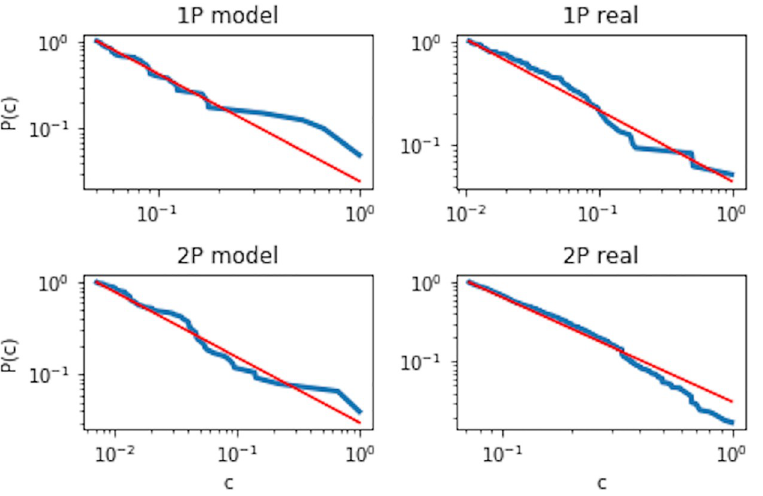
Fig 16. A comparison on the clustering coefficient distribution between the empirical and synthetic network for both periods. All distributions are observed to display power-law behavior. The red line shows the power law function with an exponent of